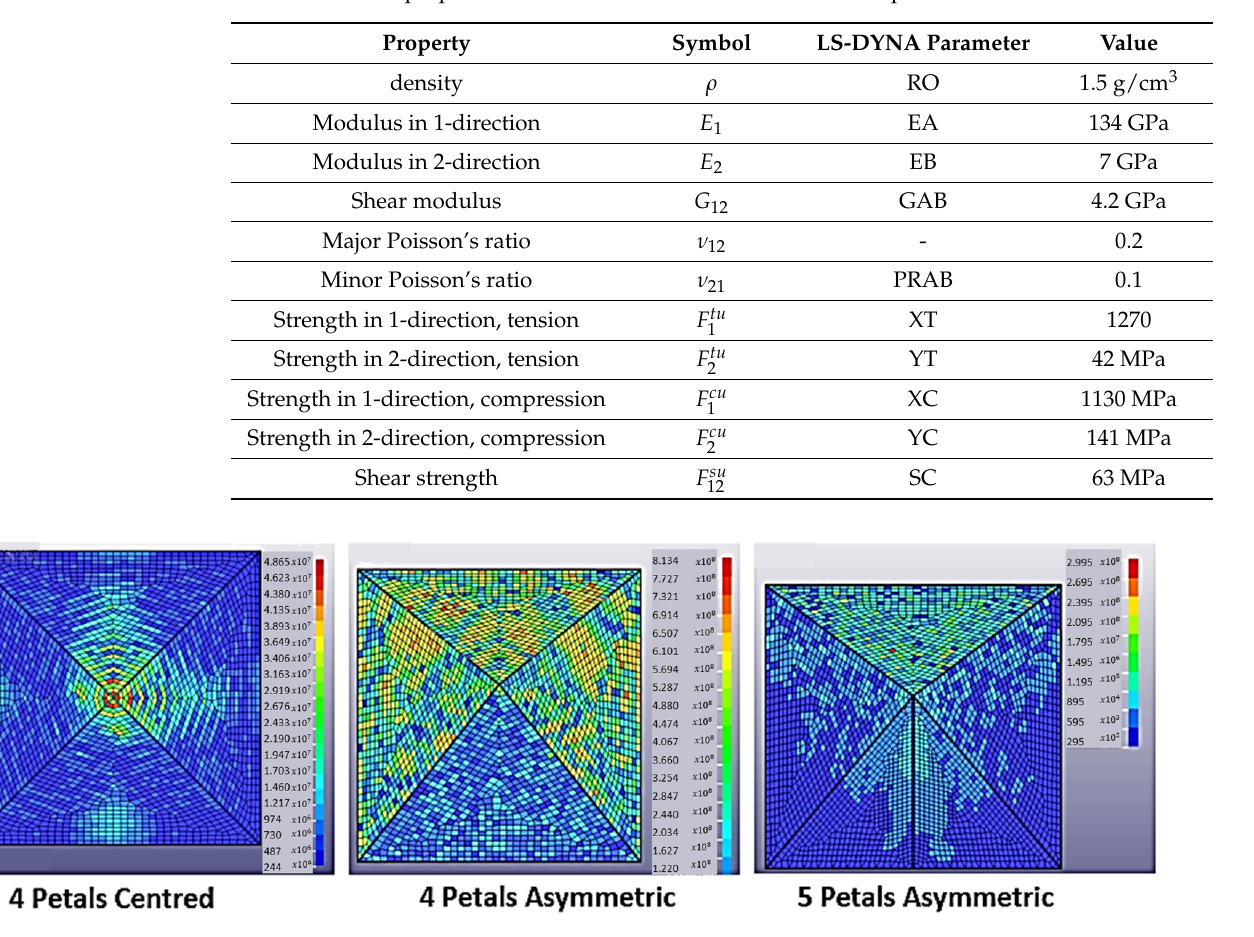
Table 3. Material properties of Carbon fiber E-862 unidirectional tape.